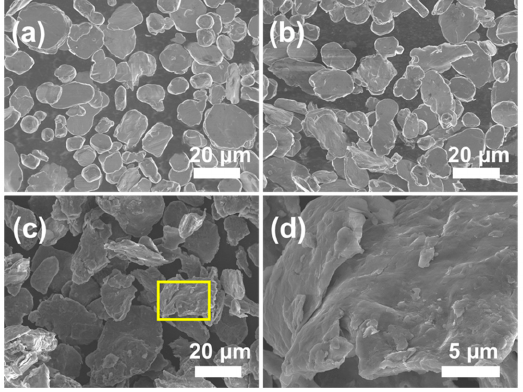
Figure 2. SEM images of ball-milled powders. ( a ) Pure Al, ( b ) 0.5 wt.% FLM/Al, ( c ) 1.5 wt.% FLM/Al, and ( d ) the amplification of the yellow box in ( c ).